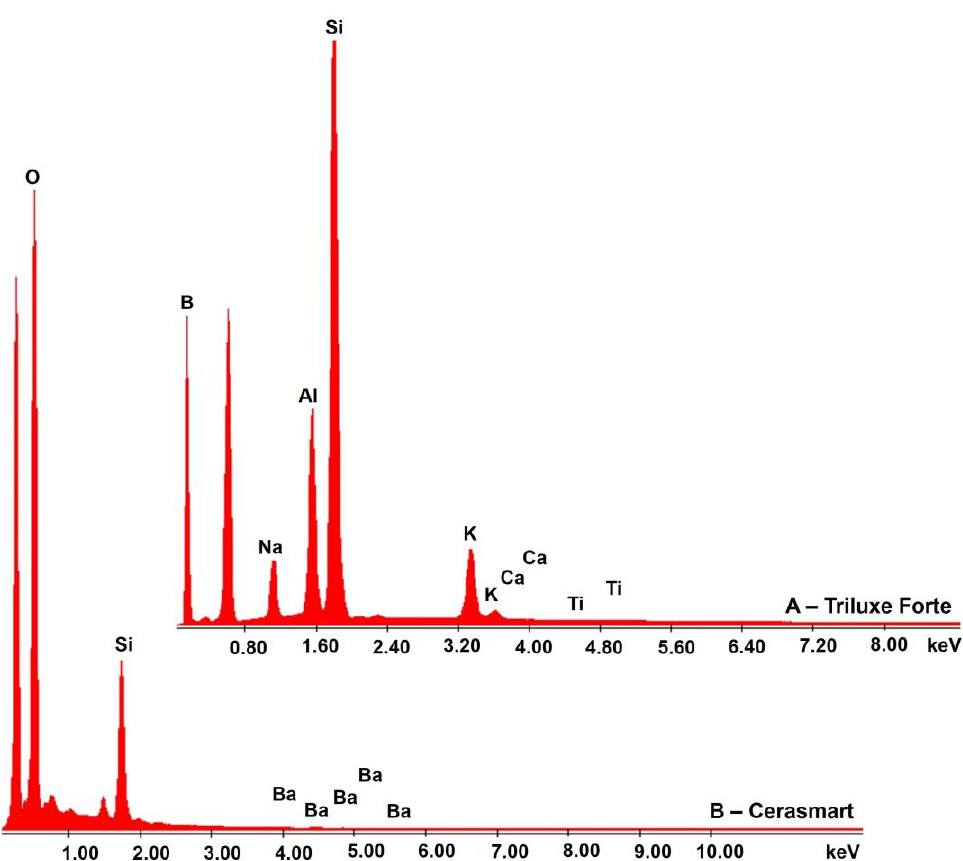
Figure 6. EDX spectra of ( A )—Triluxe Forte and ( B )—Erasmart restorative materials, after 18 h of simulated gastric acid solution exposure.